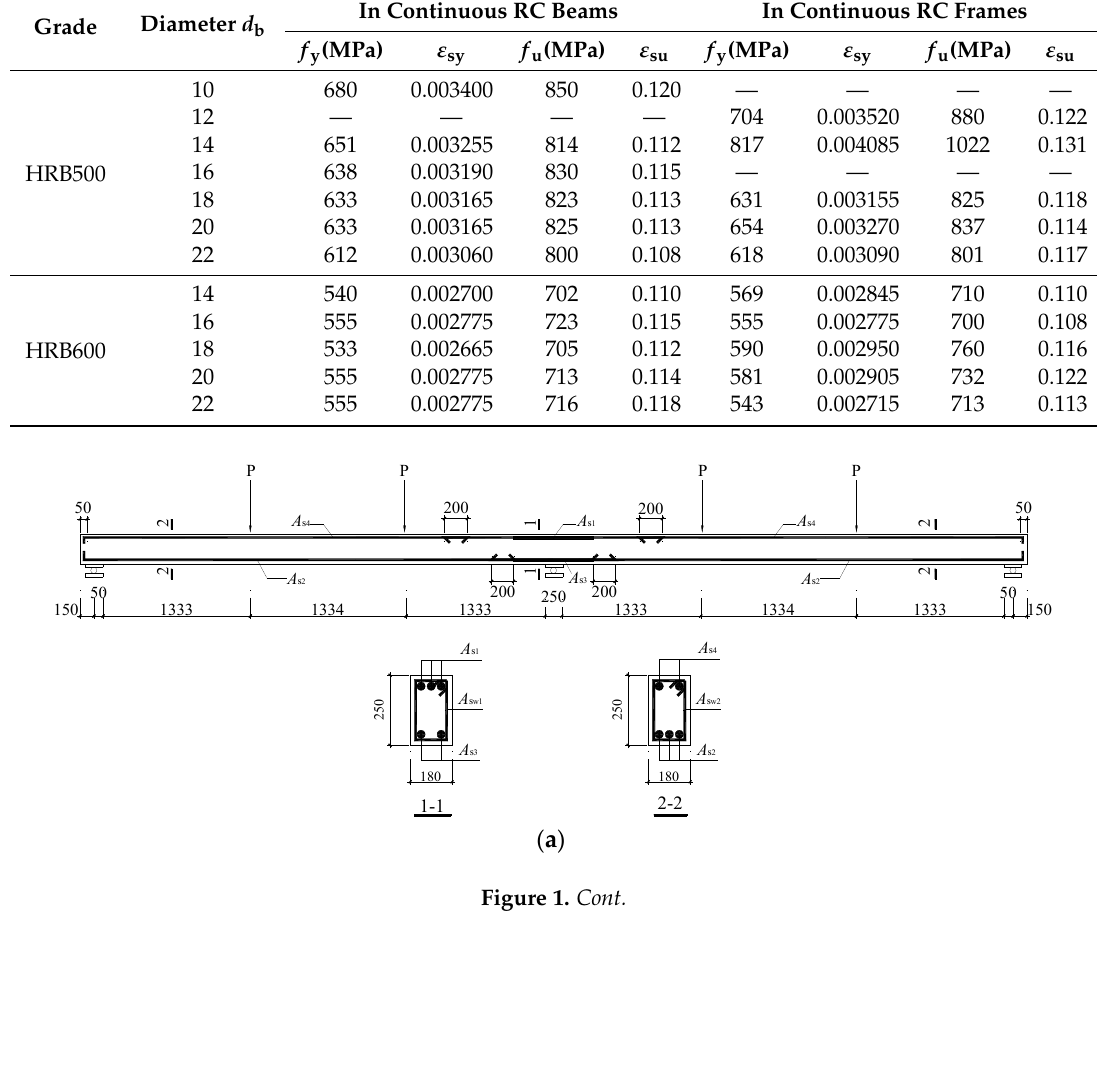
Table 1. Mechanical properties of steel bars.